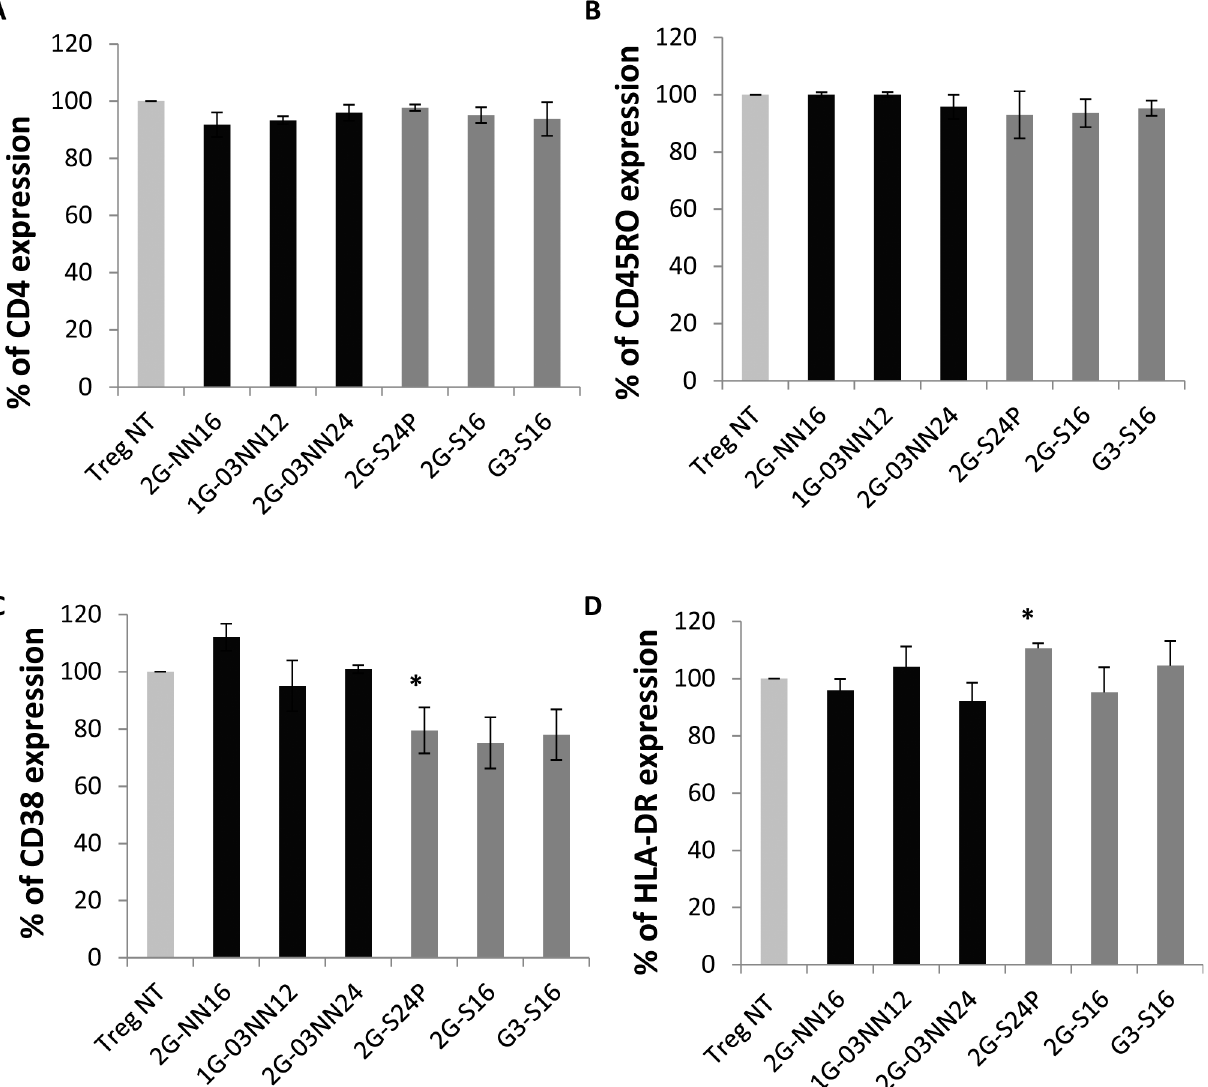
Fig 3. Phenotype expression in Treg cells treated with dendrimers. The percentage of CD4 (A), CD45RO (B), CD38 (C) and HLA-DR (D) expression was analyzed after 48 hours of Treg cells treated with cationic or anionic dendrimers. Values were calculated and normalized regarding the non-treated Treg (Treg NT) condition that was considered as 100% of expression. Average of 2G-NN16 (n = 7), 1G-03NN12 (n = 5), 2G-03NN24 (n = 7), 2G-S24P (n = 7), 2G-S16 (n = 4), and G3-S16 (n = 4) experiment (Mean + SEM). * p < 0.05 obtained with the Wilcoxon paired